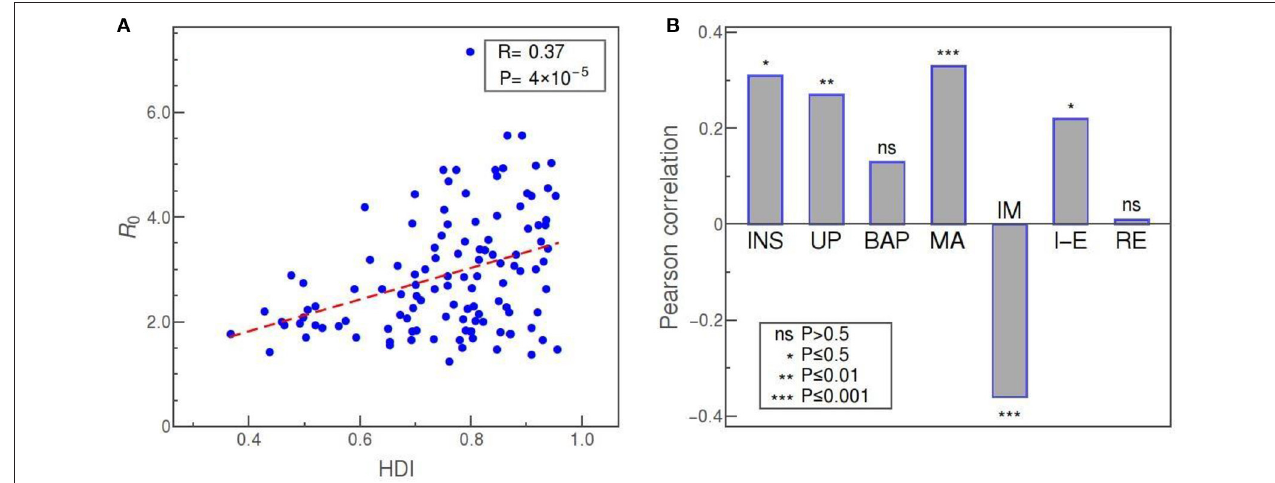
FIGURE 4 | (A) R 0 vs. HDI as an example of transmissibility dependence on demographic data (Pearson correlation denoted as R). (B) Pearson correlations of R 0 with (from left to right): social security and health insurance coverage (INS), percentage of urban population (UP), BUCAP measure of population density (BAP), median age (MA), infant mortality (IM), net migration (I-E), and percentage of refugee population by country or territory of asylum (RE). The statistical significance of each correlation is indicated in the legend, while “ns” stands for “no